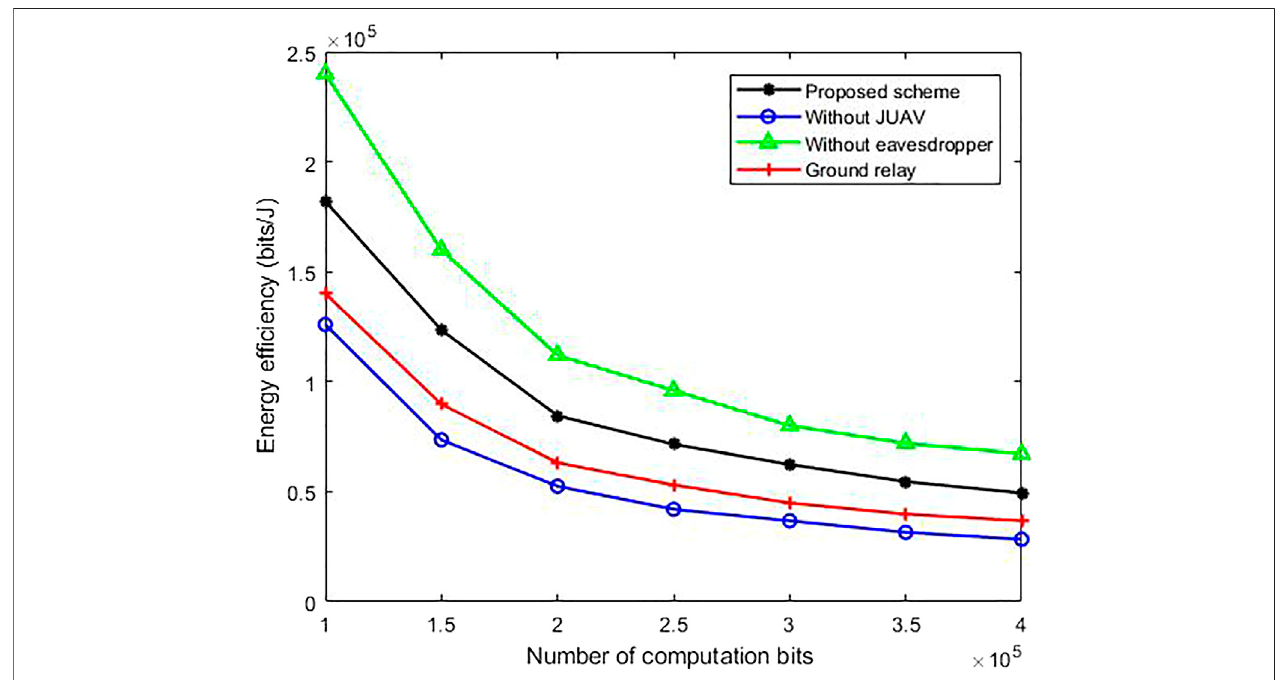
FIGURE 3 | Energy ef fi ciency vs. the number of calculated bits.